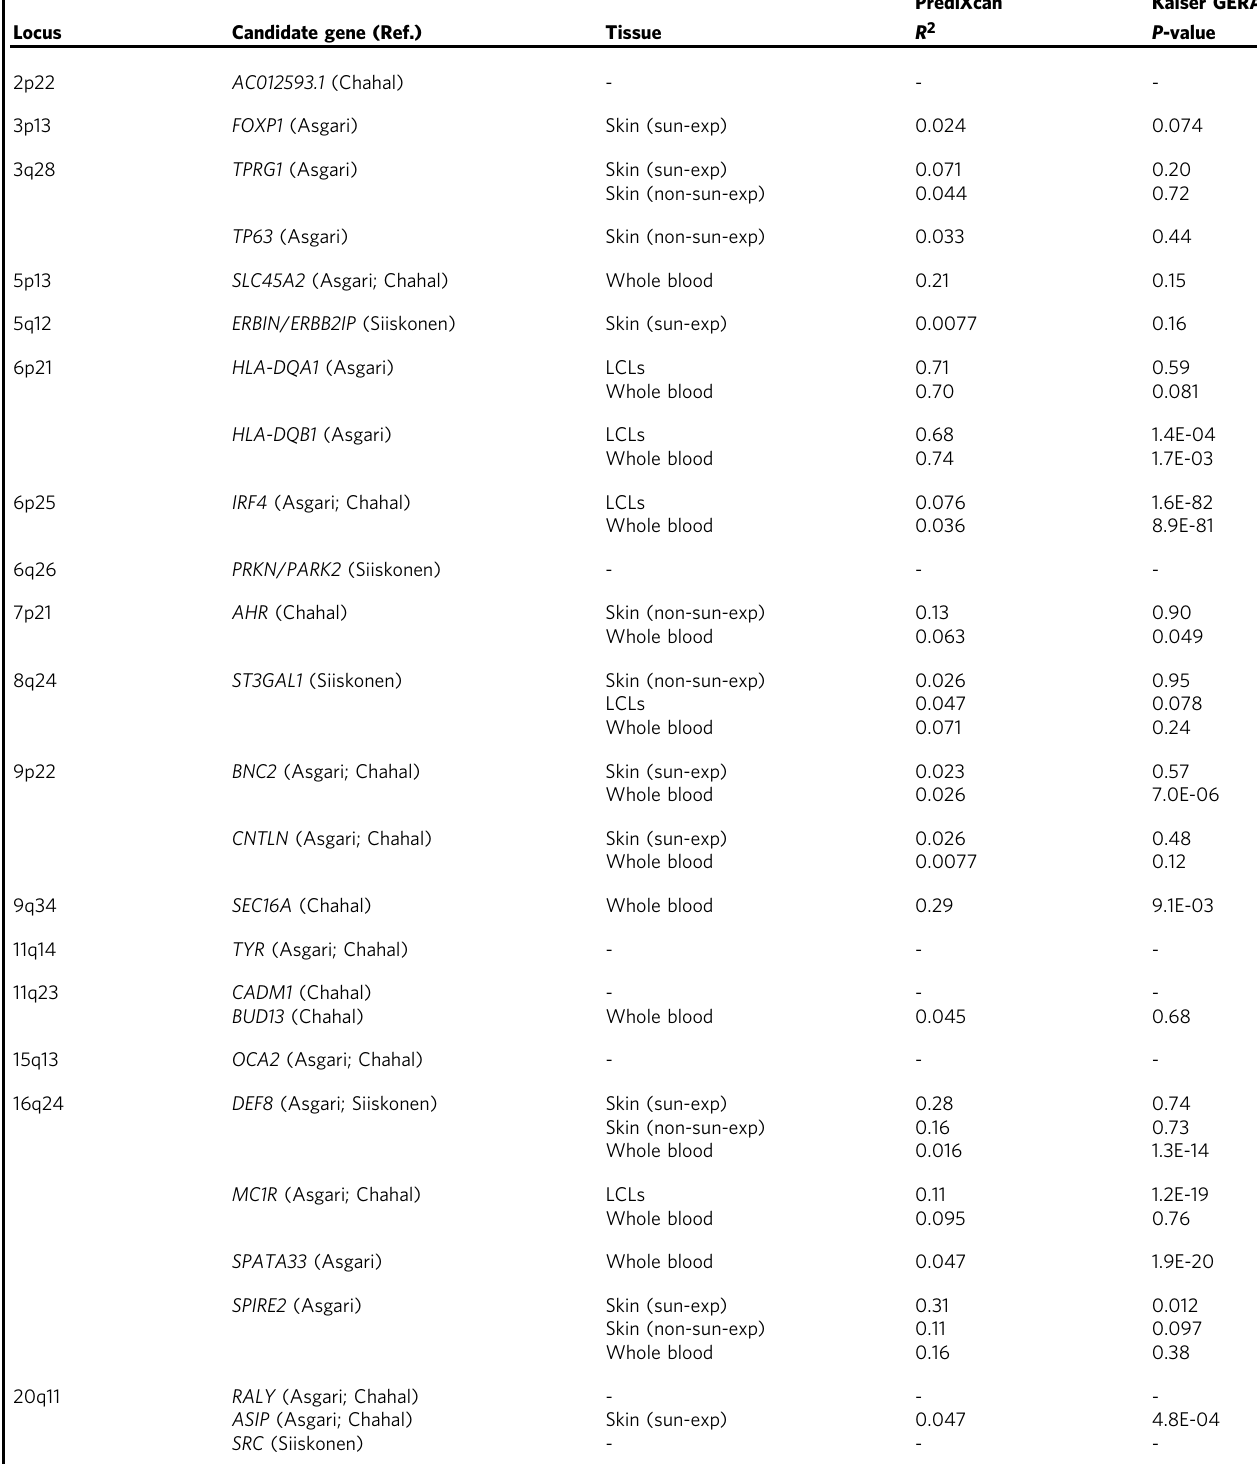
PrediXcan Kaiser GERA